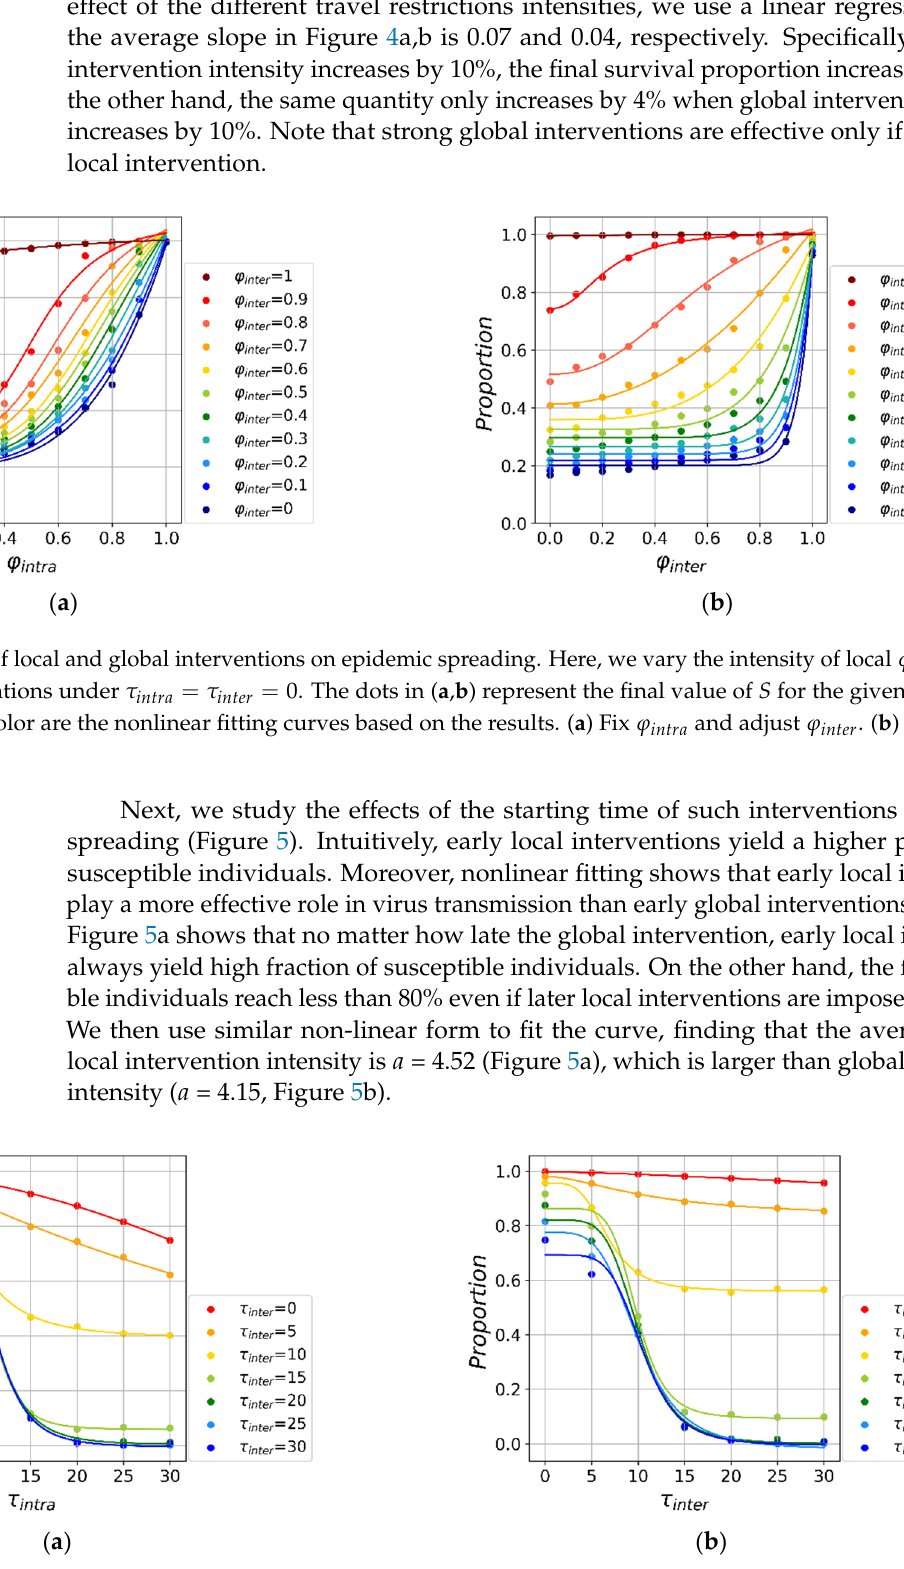
Figure 5. The effect of start time on epidemic spreading. We vary the intensity of local τ intra and global τ inter interventions under ϕ intra = ϕ inter = 0.9. The dots in ( a , b ) represent the final value of S for the given, and the curves of the same color are the nonlinear fitting curves based on the results. ( a ) Fix τ intra and adjust τ inter . ( b ) Fix τ inter and adjust τ intra